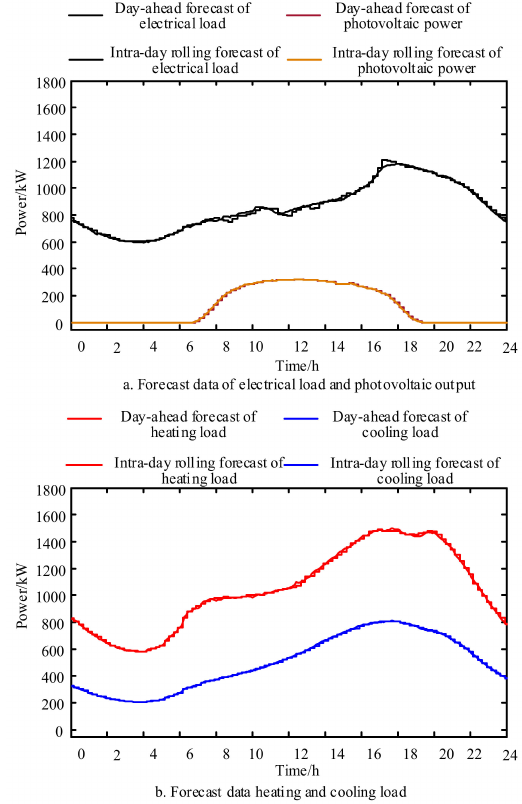
Figure 9. The day-ahead and intra-day forecast curves of PV and load output of the energy station